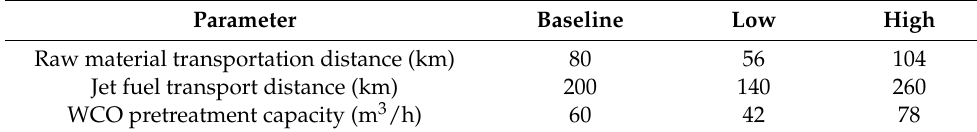
Table 1. Sensitivity analysis of different parameter.